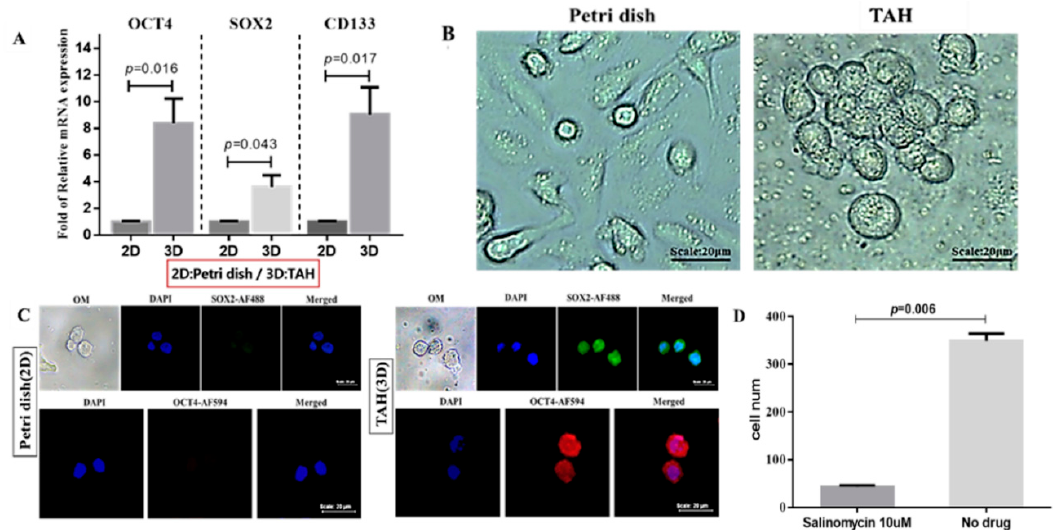
Figure 6. ( A ) Expression analysis of OCT4 , SOX2 , and CD133 at transcription level in MDA-MB-231 cells with different culture conditions where GAPDH was used as the internal control, p value < 0.05 in all three groups. ( B ) Migratory phenotypes of MDA-MB-231 cells in petri dish (2D) and TAH (3D). ( C ) Immunofluorescence staining demonstrated that MDA-MB-231 cultured in a 3D microenvironment of TAH exhibited elevated expression levels of stemness regulators in nucleus. ( D ) Homing test of MCF-7 cells treated with salinomycin or not, p value = 0.006. Values shown are mean ± SD of three independent experiments.